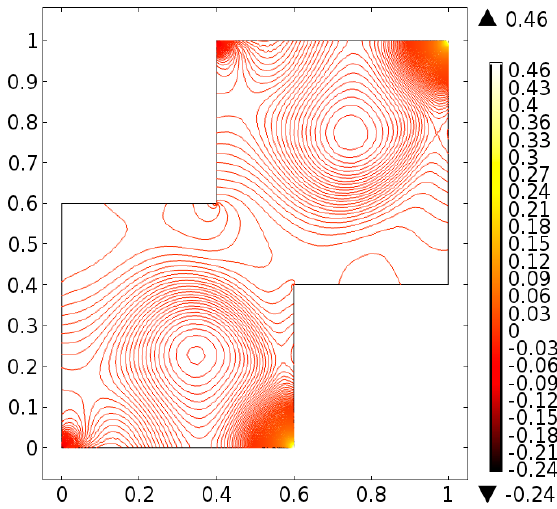
Figure 28. Pressure distribution at Re = 1000 for case-II.